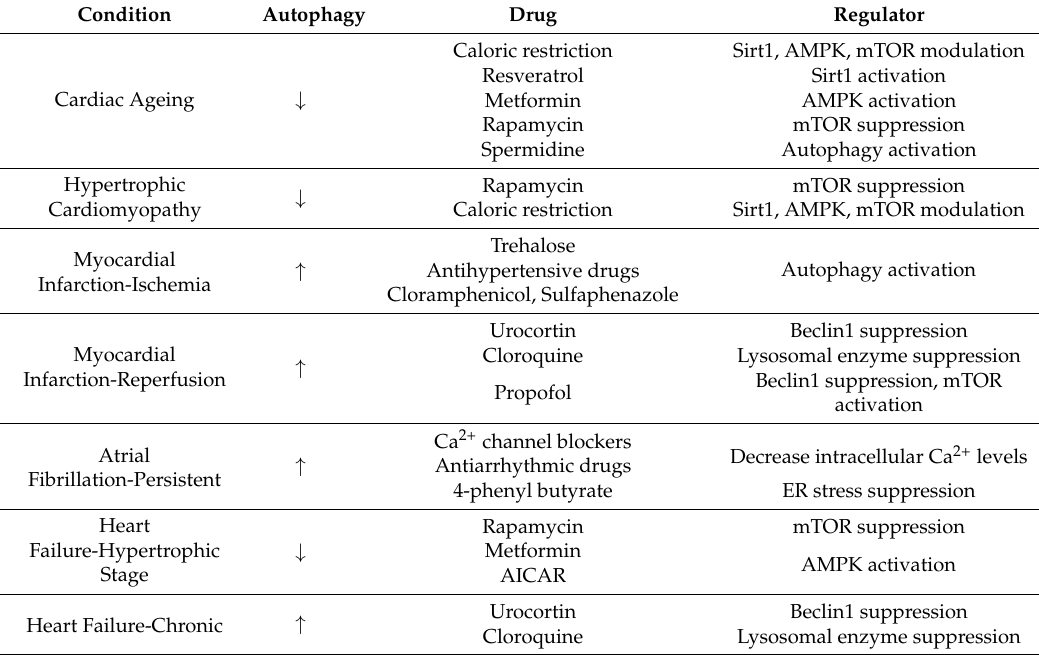
Table 2. Pharmacological targeting of autophagy in cardiac ageing and